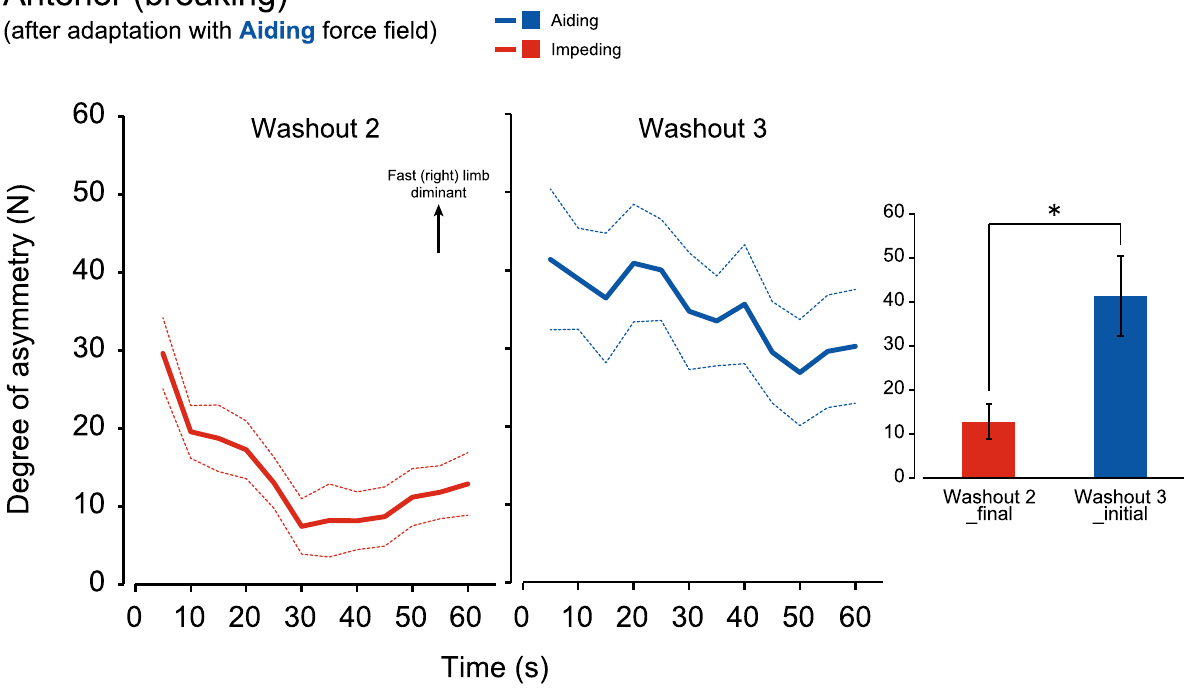
Figure 7. Degree of washout in the acquired asymmetrical movement pattern in the braking GRF component with the aiding force field by subsequent walking with the impeding force field in washout 2 ( ➁ ) and the aiding force field in washout 3 ( ➂ ) periods (n = 8). The lines represent the mean (solid) and the standard error of the mean (dotted). The bar graph compares the mean values between the last 5 s bin of washout 2 ( ➁ ) and the first 5 s bin of washout 3 ( ➂ ). The error bars represent the standard error of the mean. *P <